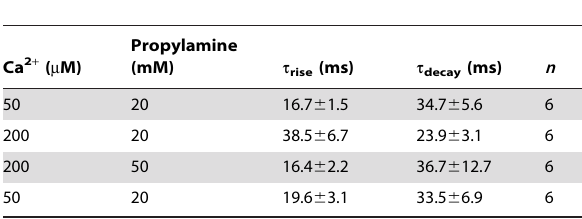
Table 1. Schild analysis of inhibition of ELIC. Table 2. Activation and deactivation kinetics of